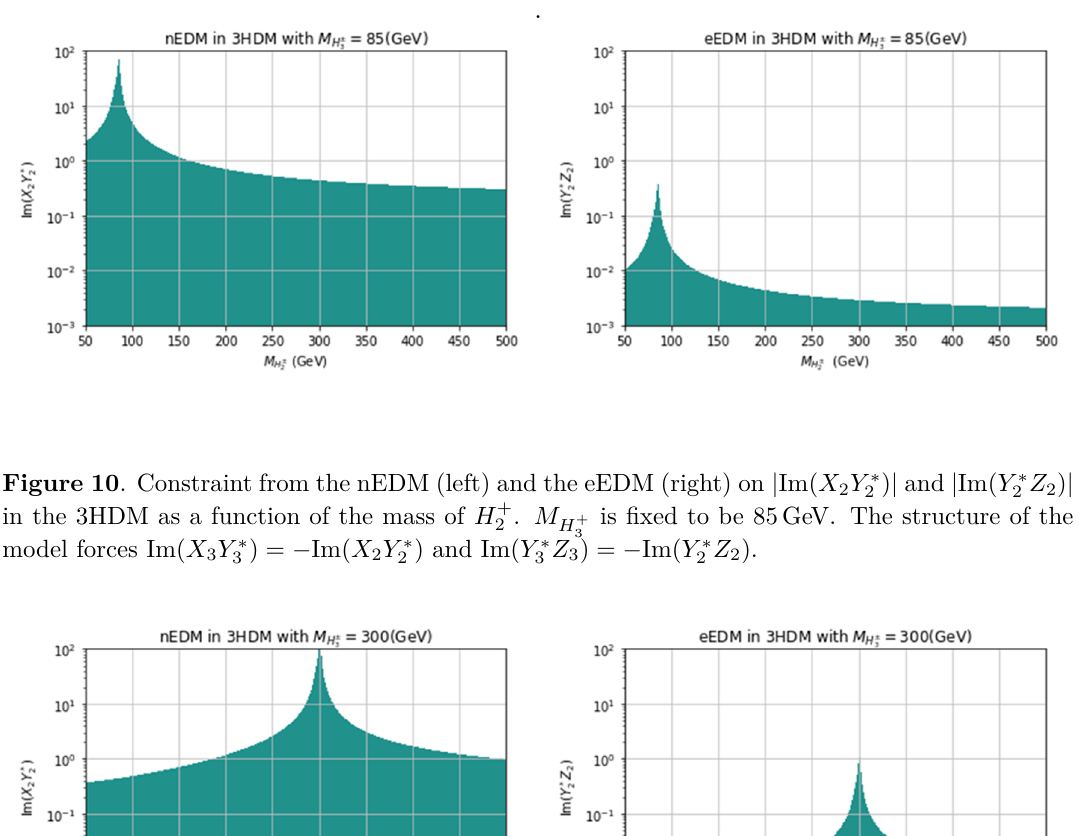
Figure 9 . Constraint from the nEDM (left) and the eEDM (right) on | Im( XY ∗ ) | and | Im( Y ∗ Z ) | , respectively, in the Aligned 2HDM as a function of the charged Higgs mass ( M shaded region is allowed.